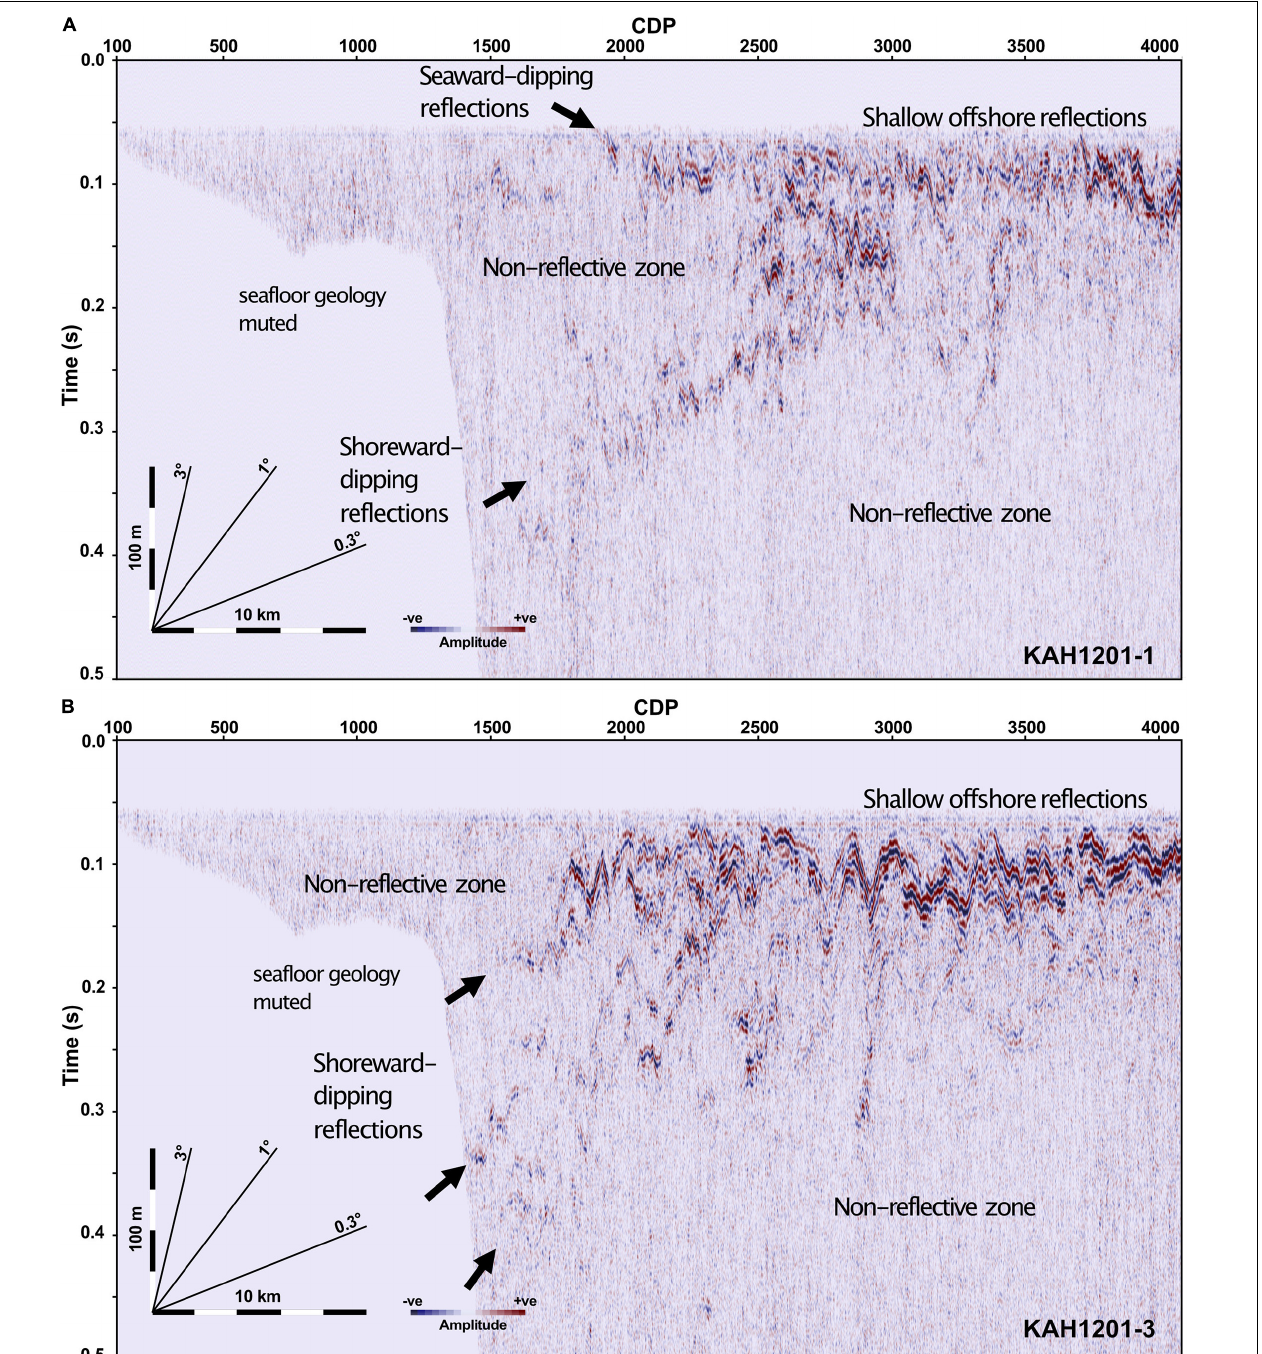
FIGURE 3 | Processed seismic images for lines (A) KAH1201-1 and (B) KAH1201-3 from the MUN transect.